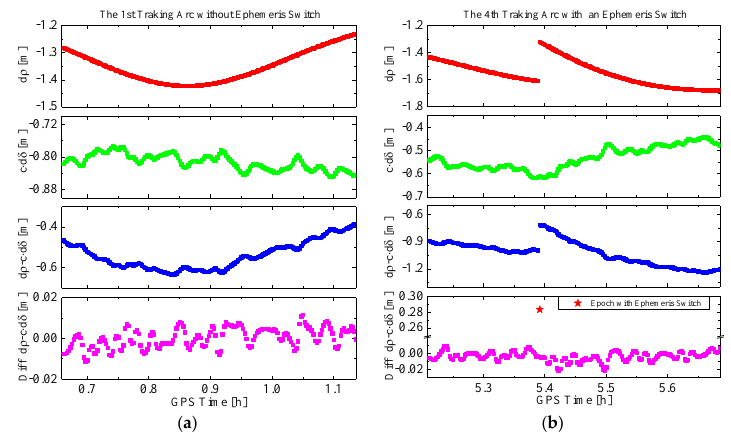
Figure 3. The LOS error and its inter-epoch difference in a tracking arc. ( a ) The first tracking arc of Figure 2 without ephemeris switch; and ( b ) the fourth tracking arc of Figure 2 with an ephemeris switch.